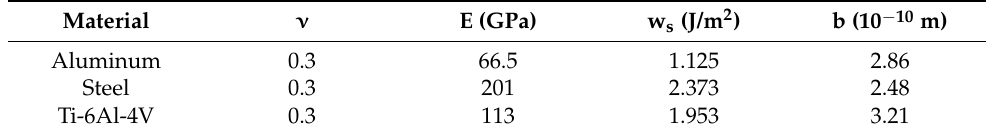
Table 2. Material physical